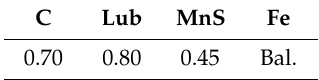
Table 1. Chemical composition of the sintered Fe-based high C steel in (wt %).